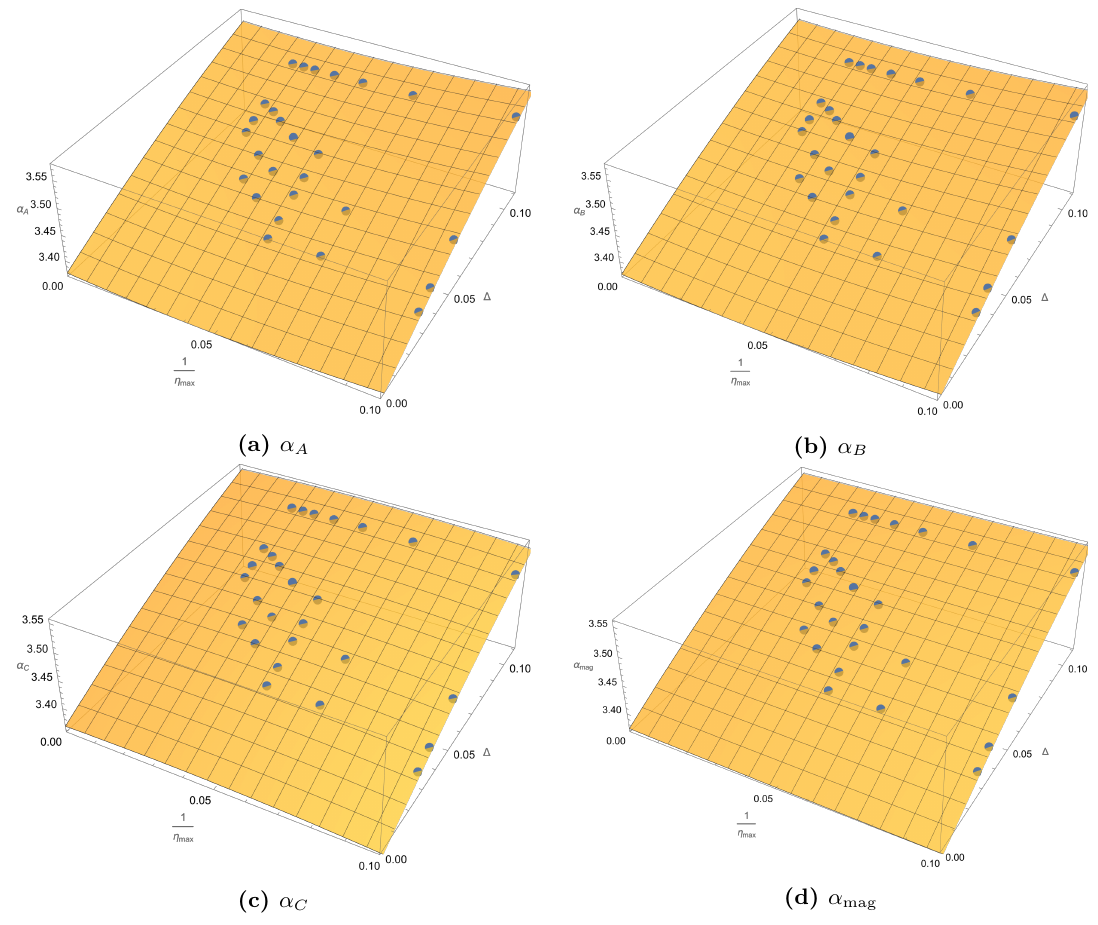
Figure 4. Plots of the approximate intercepts (blue dots) for the numerically calculated dipoles at each point in the (1 /η max , ∆) plane as well as the best fit quadratic surface for each amplitude. The continuum limit 1 /η max → 0 , ∆ → 0 corresponds to the lower left